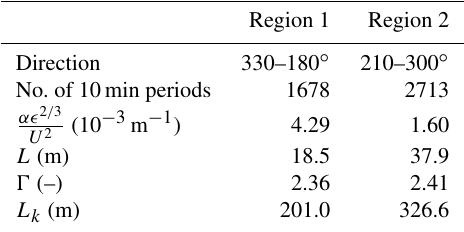
Table 2. Measurement sectors and fitted Mann model and (cid:48) ) and Kaimal model ( L k )